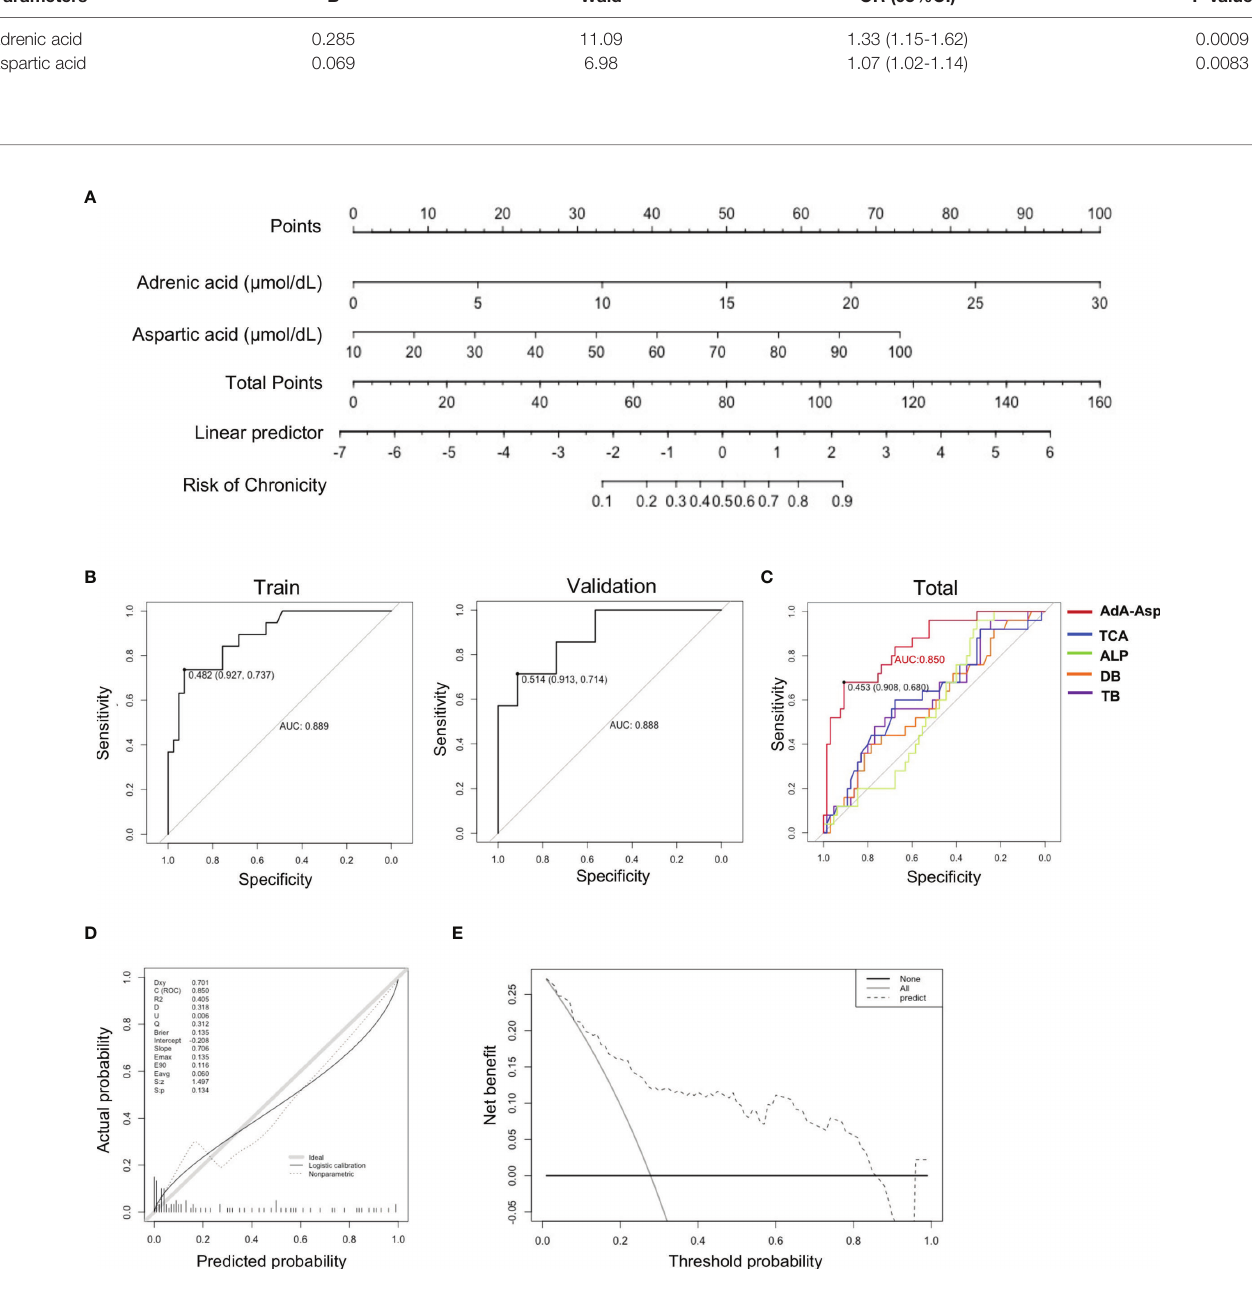
FIGURE 5 | Predictive model establishment based on serum metabolites. (A) Nomogram based on serum metabolites for the prediction of DILI chronicity. (To use the nomogram, an individual patient ’ s value is located on each variable axis, and a line is drawn upward to determine the number of points received for each variable value. The sum of these numbers is located on the Total Points axis, and a line is drawn downward to the survival axes to determine the risk of chronicity in DILI.) (B) Plots of ROC results from the discovery set and the validation set.for distinguishing DILI.chr fromDILI.rec. The ROC curves were created by plotting the sensitivity (i.e., true positive rate) against 1-speci fi city (i.e., false positive rate). The line in each plot represents the area under the curve (AUC). (C) Plots of ROC results for distinguishing DILI.chr from the DILI.rec with ‘ AdA-Asp model ’ (Adrenic acid and Aspartic acid), TCA, ALP, DB and TB respectively. (D) Calibration plot to assess the accuracy of the model in the validation set. (E) Decision curve analysis plot to assess the clinical utility of the ‘ AdA-Asp model ’ (Decision curve analysis was based on a continuum of potential thresholds for chronicity risk (x axis) and the net bene fi t of using the model to risk stratify patients (y axis) relative to assuming that no patient will progress to chronic DILI. The thick black line represents the net bene fi t of assuming that none DILI patients would progress to chronic DILI; the thin grey line shows the net bene fi t of assuming that all would progress to chronic DILI. The black dotted line illustrates the net bene fi t of predicting the risk of DILI using the AdA- Asp model.). ROC, receiver operating characteristic; AUC, area under the curve; ALP, alkaline phosphatase; DB, direct bilirubin; TB, total bilirubin; Asp, aspartic